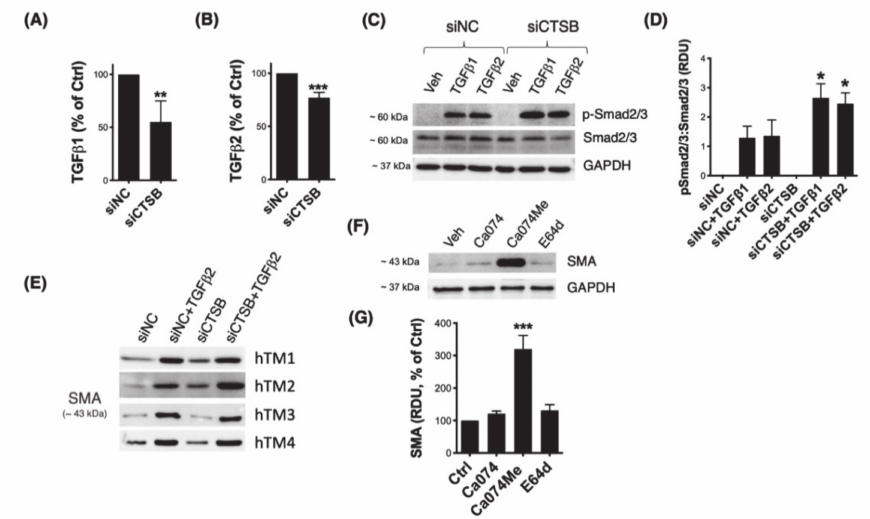
Figure 5. Effect of CTSB deficiency on TGF β signaling. Secreted levels of ( A ) TGF β 1 and ( B ) TGF β 2 were quantified by ELISA in culture media from hTM primary cultures transfected with siCTSB or siNC control for 72 h. Data are shown as the mean ± S.D. **, p < 0.01; ***, p < 0.001, t -test, n TGF β 1 = 6, n TGF β 2 = 4. ( C ) Protein levels of pSmad2/3 and Smad2/3 in whole-cell lysates (5 µ g) from hTM cells transfected with siCTSB or siNC for 72 h and subjected to TGF β 1 (10 ng/mL) or TGF β 2 (10 ng/mL) treatment for 48 h. Relative pSmad2/3 protein levels calculated from densitometric analysis of the bands are represented in ( D ). Data are shown as the mean ± S.D. *, p < 0.05 ANOVA with Tukey comparison tests, n = 3. ( E ) Protein levels of SMA in whole-cell lysates (5 µ g) from four independent hTM strains transfected with siCTSB or siNC for 72 h and subjected to TGF β 2 (10 ng/mL) or TGF β 2 (10 ng/mL) treatment for 48 h. ( F ) Protein levels of SMA in whole-cell lysates (5 µ g) from hTM cells treated with Ca074 (40 µ M), Ca074Me (40 µ M), or E64d (10 µ M) for 24 h. Relative SMA protein levels calculated from densitometric analysis of the bands are represented in ( G ). Data are shown as the mean ± S.D. ***, p < 0.001, t -test, n =